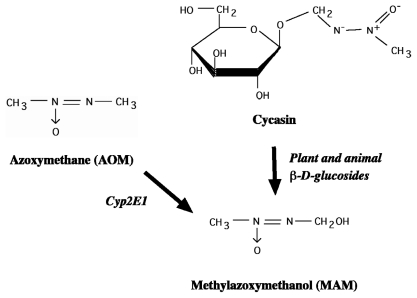
Structure of the cycad genotoxins cycasin (methylazoxymethanol-β-D-glucoside), methylazoxymethanol (MAM) and the related compound azoxymethane (AOM). The azoxyglycoside cycasin is converted to MAM by plant and animal β-glucosidases whereas azoxymethane is converted to MAM by mixed function oxidases (i.e., P450 Cyp2E1).